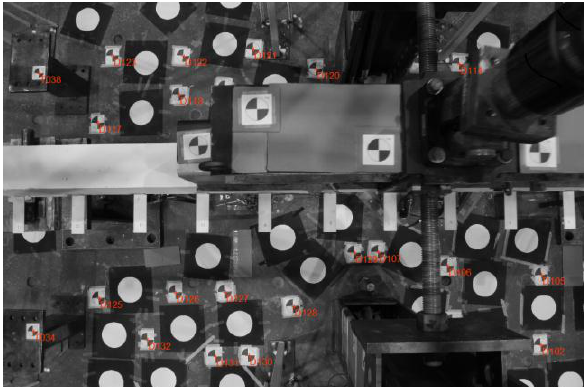
Figure 6. Example of the distribution of signalized targets on the floor for the relative orientation estimation